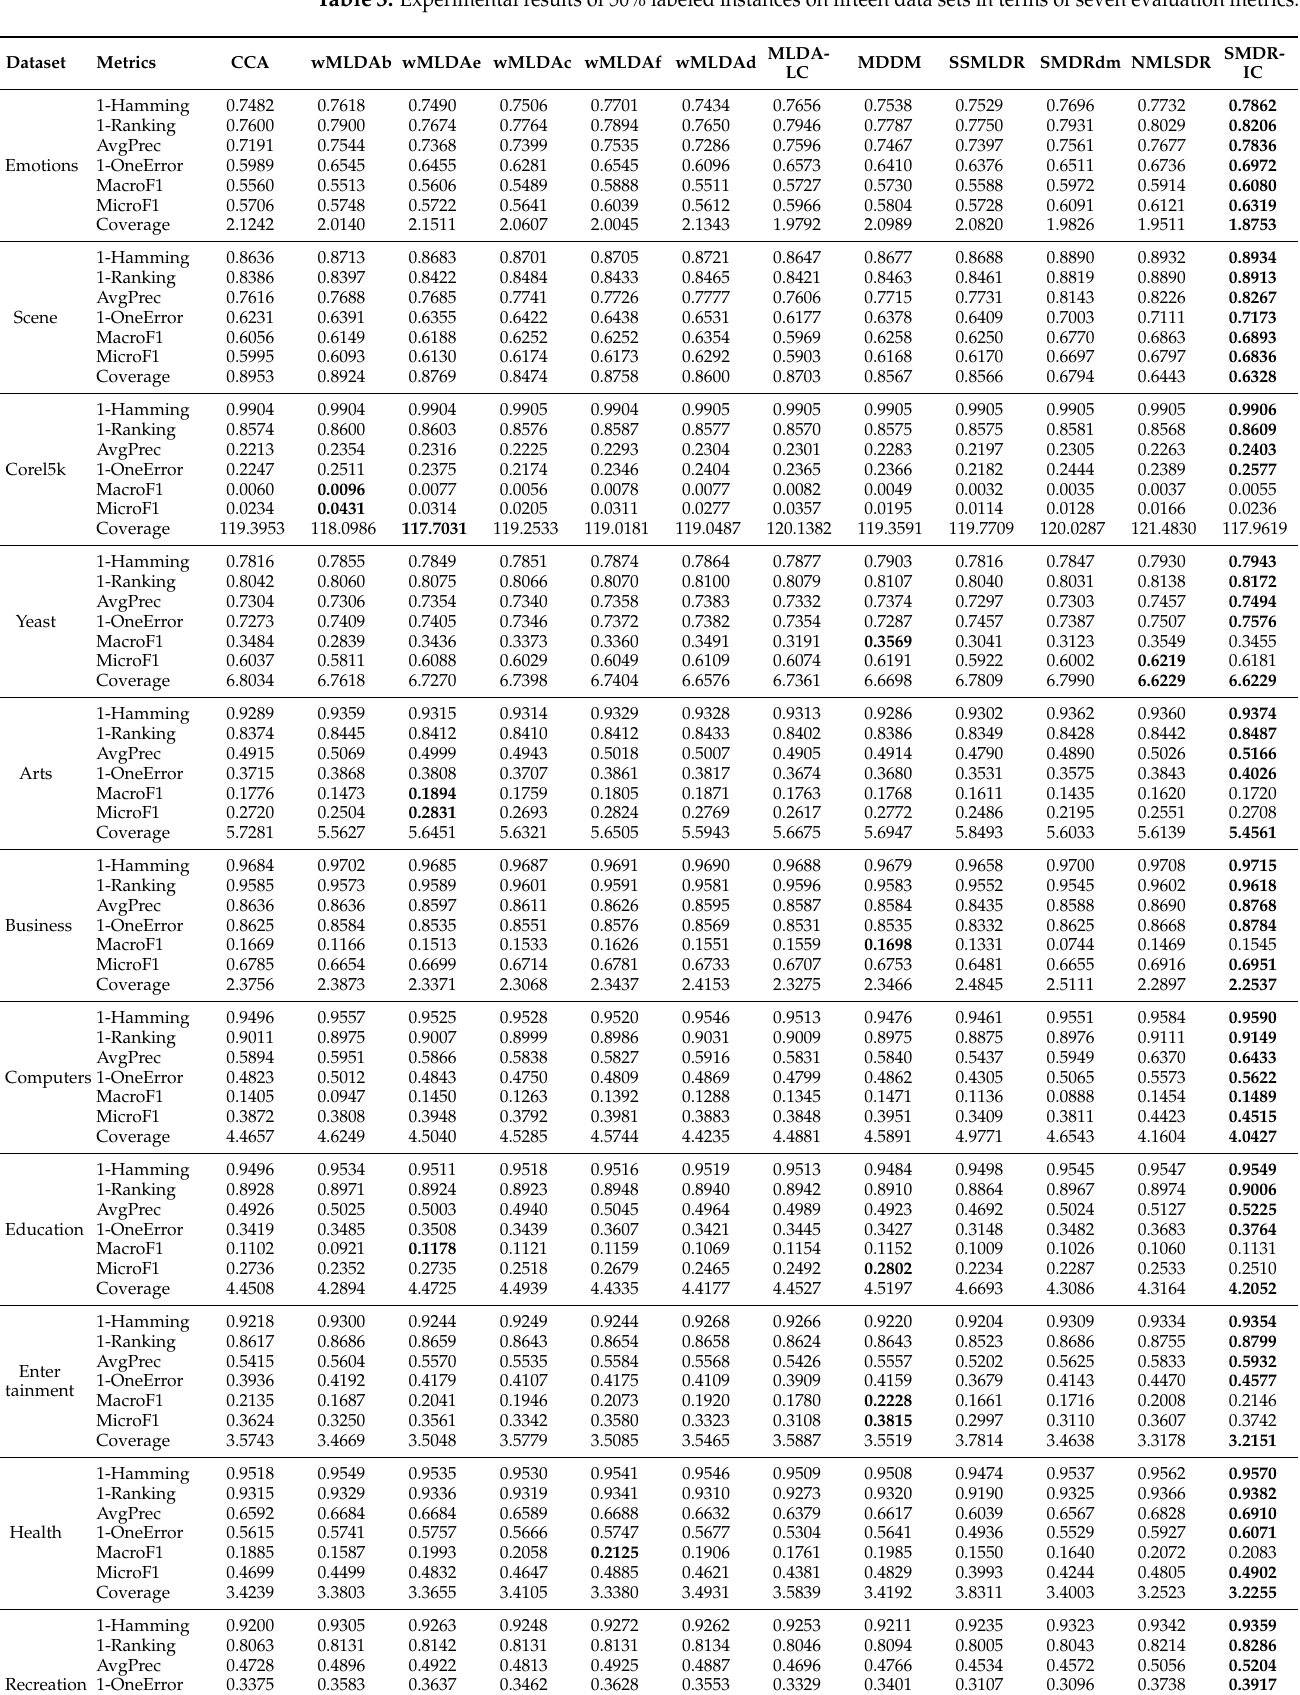
Table 3. Experimental results of 50% labeled instances on fifteen data sets in terms of seven evaluation